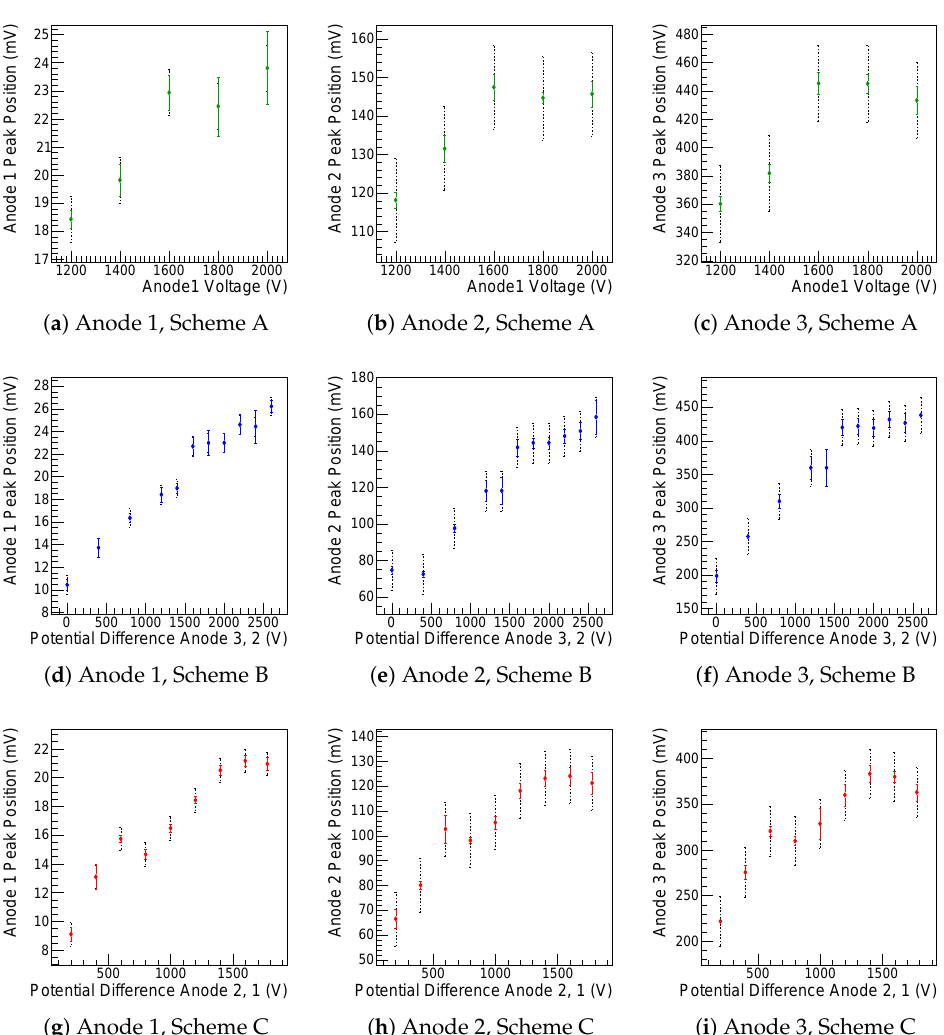
Figure 21. Plots of the position of the α -peak in the respective amplitude spectra. In the first row ( a – c ) the peak position is plotted vs. anode 1 voltage (Scheme A). During Scheme A, the voltages of all three anodes are increased in steps of 200V, while the potential difference between anodes is kept constant. In the second row (Scheme B: d – f ) the peak position is plotted vs. the potential difference between anodes 2 and 3 ( ∆ V a 23 ). During the measurement V a 1 , V a 2 and ∆ V a 12 are kept constant. Third row (Scheme C: g – i ): Peak position vs. the potential difference between anodes 1 and 2 ( V a 12 ), while V a 1 and ∆ V a 23 are kept constant. All of the measurements have been made in the same gas fill of 3bar absolute of pure